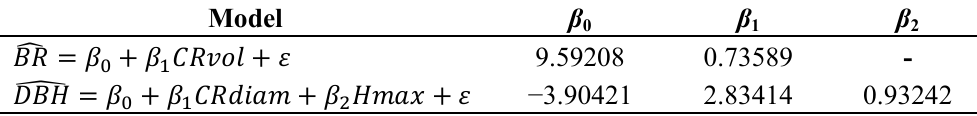
Table 5. Parameter values for the fitted linear regression models (described in Section